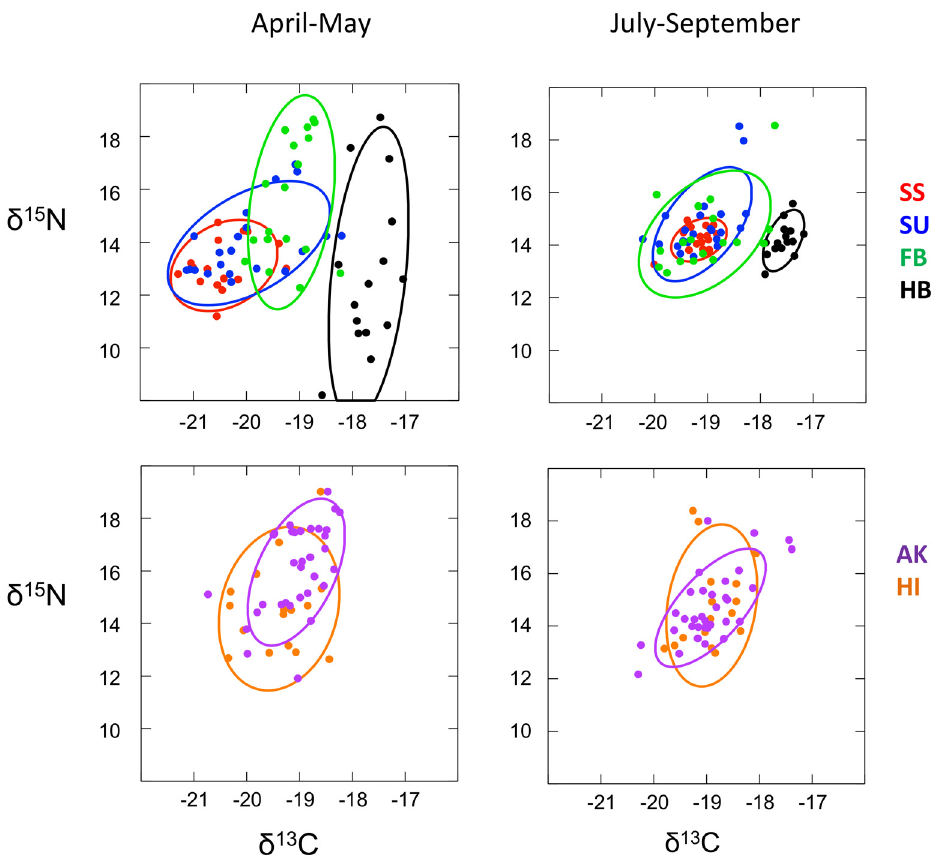
Fig 3. Nitrogen and carbon stable isotope values from individual Laysan albatross foraging during April-May (breeding season) and July-September (non-breeding season) as a function of sampling category. SS = sequentially successful breeders (fledged a chick in 2006 and 2007; feather samples from 2006); SU = sequentially unsuccessful breeders (fledged a chick in 2006, failed during incubation in 2007; feather samples from 2006); FB: failed breeders (failed during incubation in 2006, laid an egg in 2007; feather samples from 2006); HB: historic colony birds ( δ 13 C not corrected for the Suess Effect); Hawaiian fisheries- bycaught birds; and Alaskan fisheries-bycaught birds. Ellipses encompass 75% of the estimated distribution for each